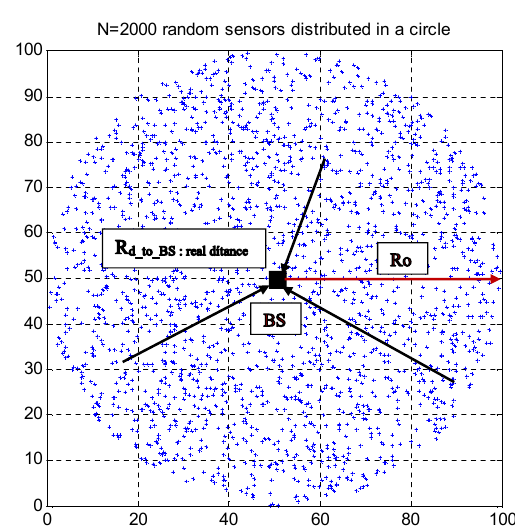
Figure 10. Consider real distances from CHs to the BS in a circular area arbitrary network